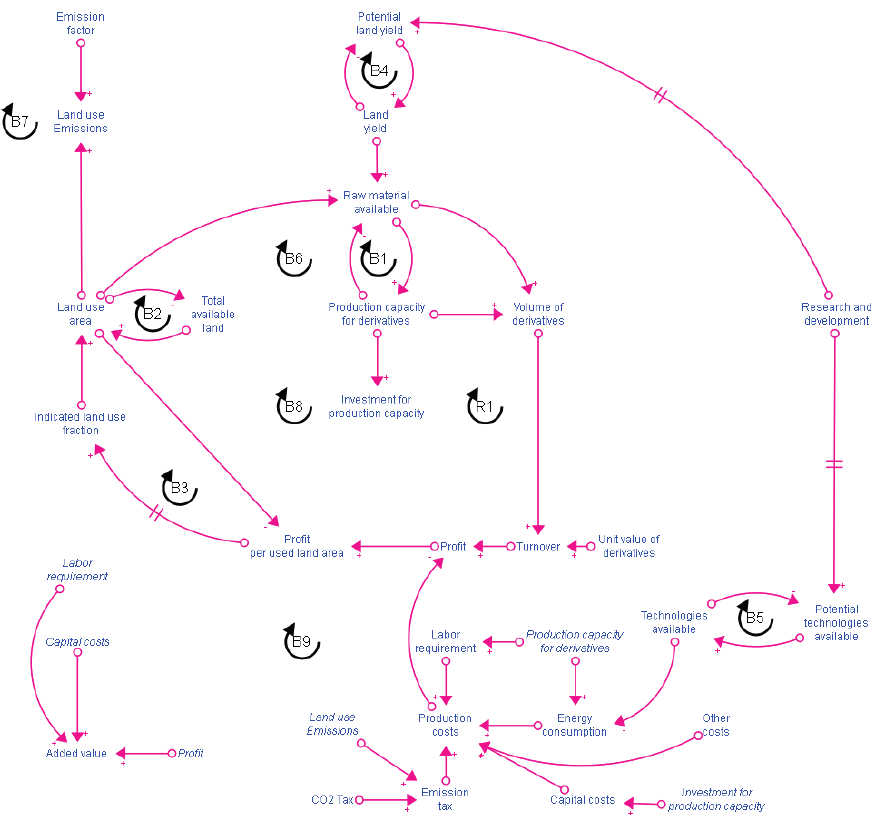
Fig. 4. Causal loop diagram of agriculture